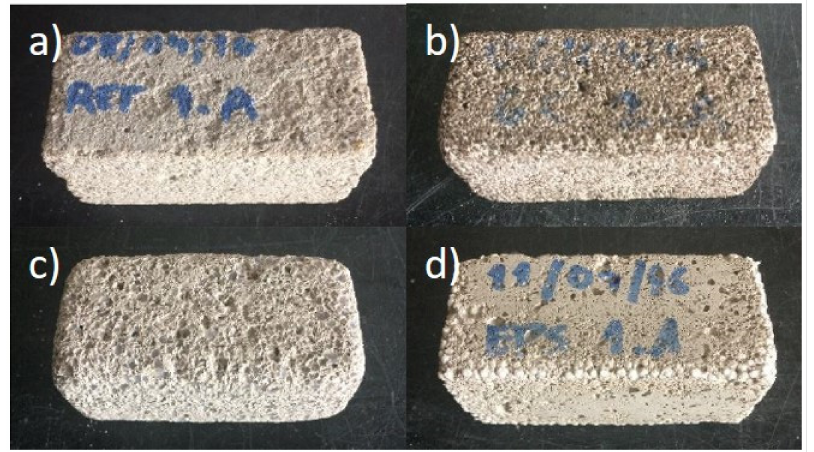
Figure 2. Half standard specimens after freeze/thaw cycles: ( a ) A(SS); ( b ) B(GEC); ( c ) C(SA); ( d ) D(EPS).